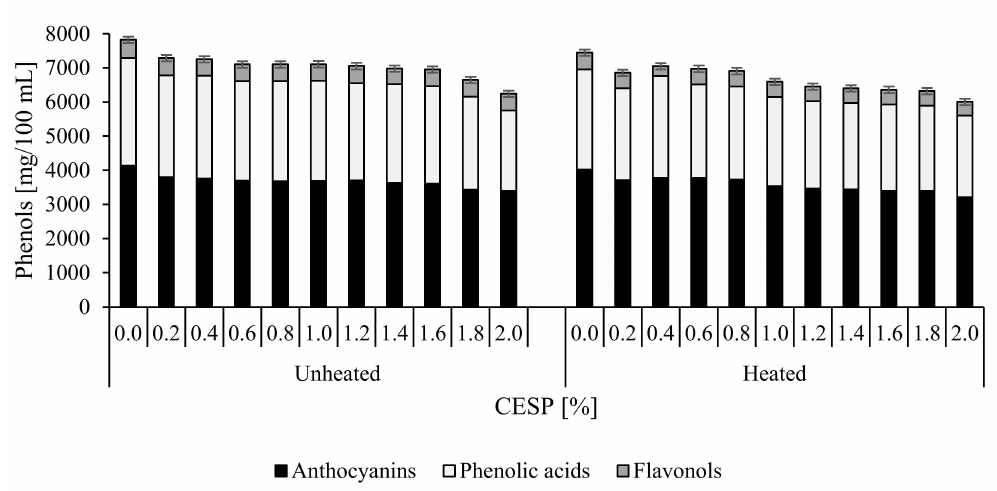
Figure 5. Polyphenolic content in the chokeberry juice with CESP before and after thermal